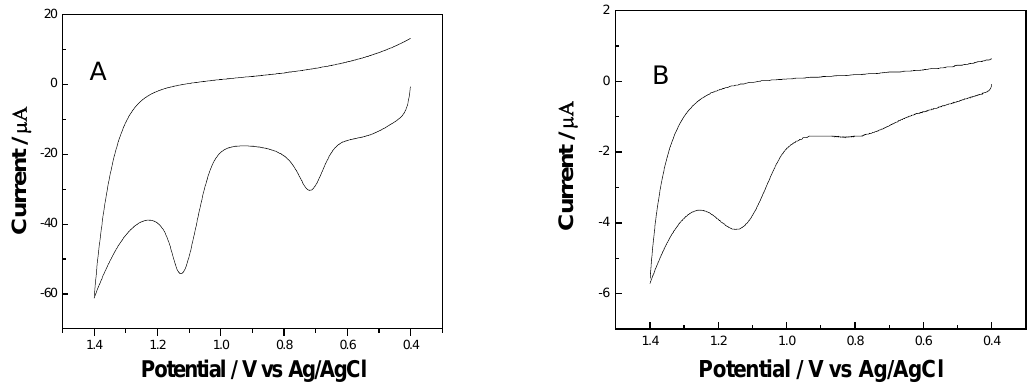
Figure 3. Cyclic voltammograms of 5.0 × 10 -7 M meloxicam at different modified GCEs. (A) cysteic acid/GCE; (B) Nafion/GCE. Scan rate: 100 mV·s -1 ; accumulation potential under stirring: - 0.2 V; accumulation time: 300 s; quiet time: 30 s; electrolyte: B-R buffer solution (0.04 M, pH